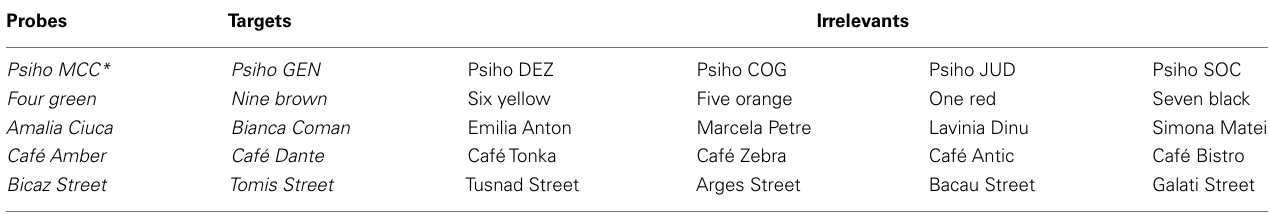
TableA1 | Items (English translation) derived from the mock crime and used in the RT-based